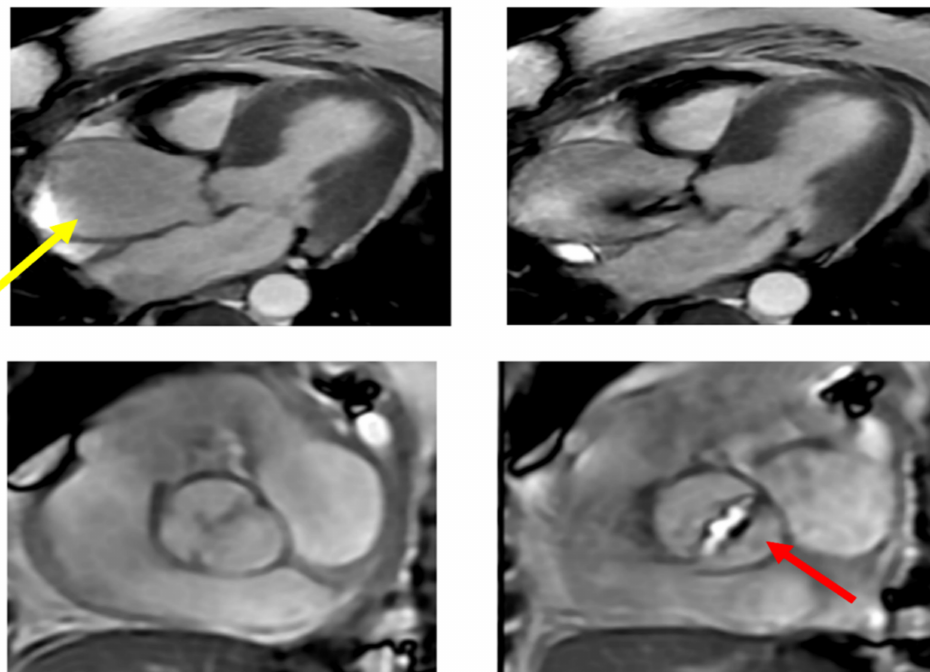
Figure 9. Calcific bicuspid aorta Sievert Type 2 with fusion of the two coronary cusps for a raphe (red arrow). The patient had a transvalvular gradient of 40 mmHg. The ascending thoracic aorta is dilated above the Valsalva sinuses with a maximum diameter of 53 mm measured at the intersection with the right pulmonary artery (yellow